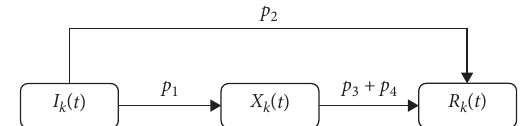
Figure 2: Transformation relationships and interaction rules represent probability of transforming among I, X, and R where p 1 from I to X after contacting X called information spreading rate; p 2 represents probability of transforming from I to R after contacting X ; p represents probability of transforming from X to R after 3 represents contacting X called self-purification level; and p 4 probability of transforming from X to R spontaneously, called forgetting